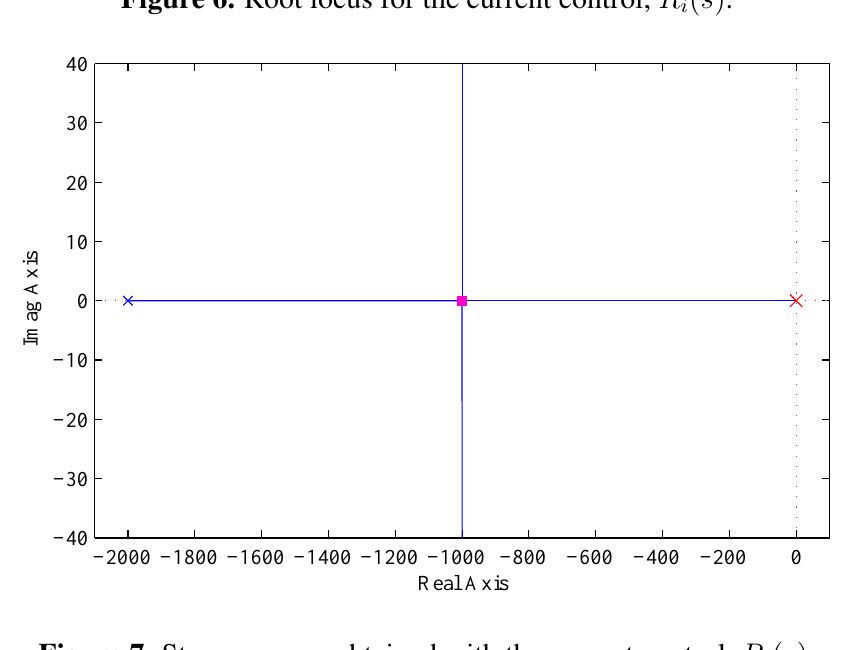
Figure 6. Root locus for the current control, R i ( s ) .